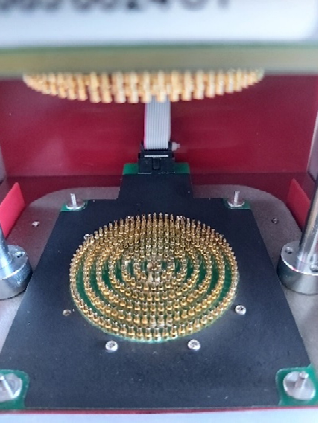
Figure 2. A view of the tester sensors MMT290. Table 4. Grading of moisture management test (MMT) indices (AATCC 195).